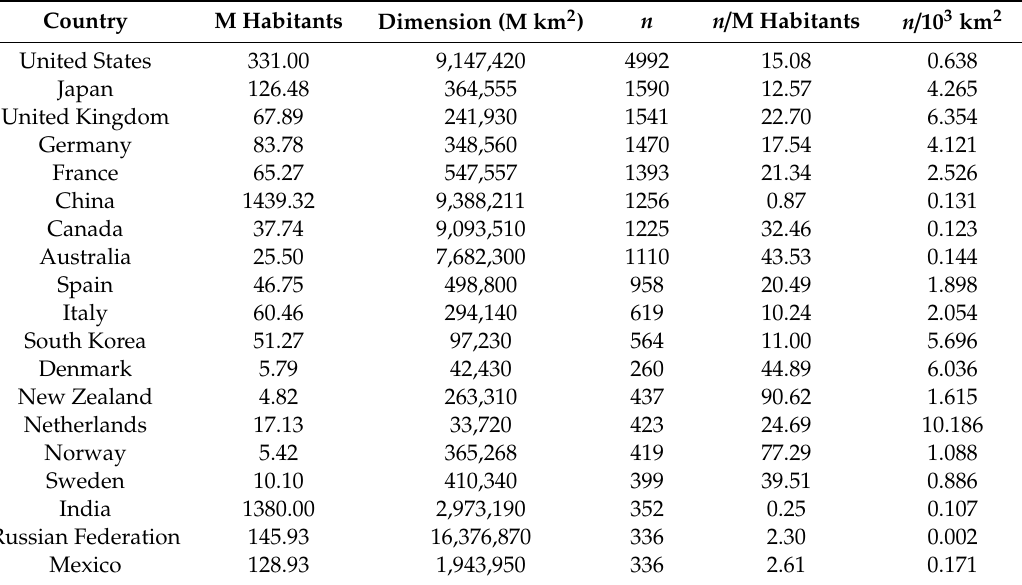
Figure 2. World map according to the number of documents. Table 1. Publications (n) distribution by